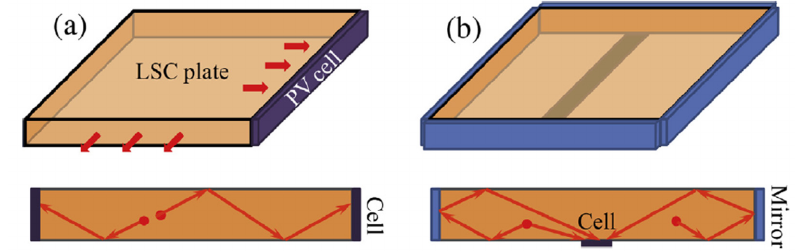
Figure 18. Illustration of a luminescent solar concentrator with ( a ) side-mounted and ( b ) bottom-mounted solar cells [70].